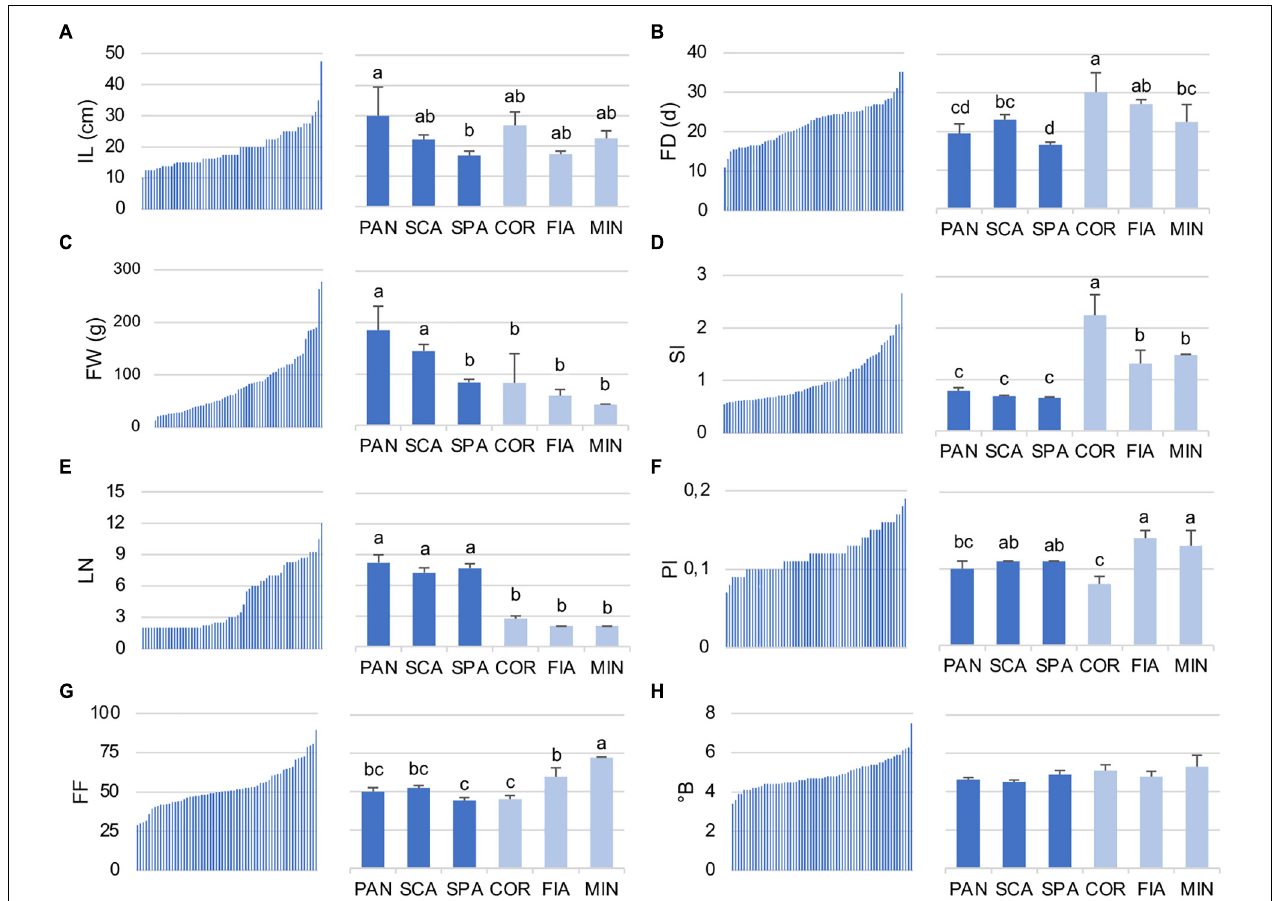
FIGURE 3 | Distribution of selected quantitative traits in the 64 analyzed tomato accessions (A) internode length (IL), (B) flowering date (FD), (C) fruit weight (FW), (D) shape index (SI), (E) locule number (LN), (F) pericarp index (PI), (G) firmness (FI), and (H) total soluble solids ( ◦ B). For each descriptor, the range of values within the entire collection (left) and the ANOVA among the named landraces (right) are reported. Flat and non-flat named landraces are represented in dark and light blue, respectively. PAN, Pantano; SCA, Scatolone; SPA, Spagnoletta; COR, Corno di toro; FIA, Fiaschetta; MIN, Da secca di Minturno. In the right subpanels, means indicated by different lowercase letters are significantly different ( p ≤ 0.05) after Duncan’s multiple range